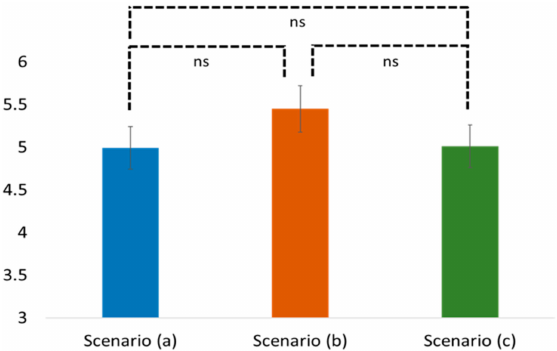
Figure 2. Comparison of religiosity in di ff erent scenarios. Note: ns stands for